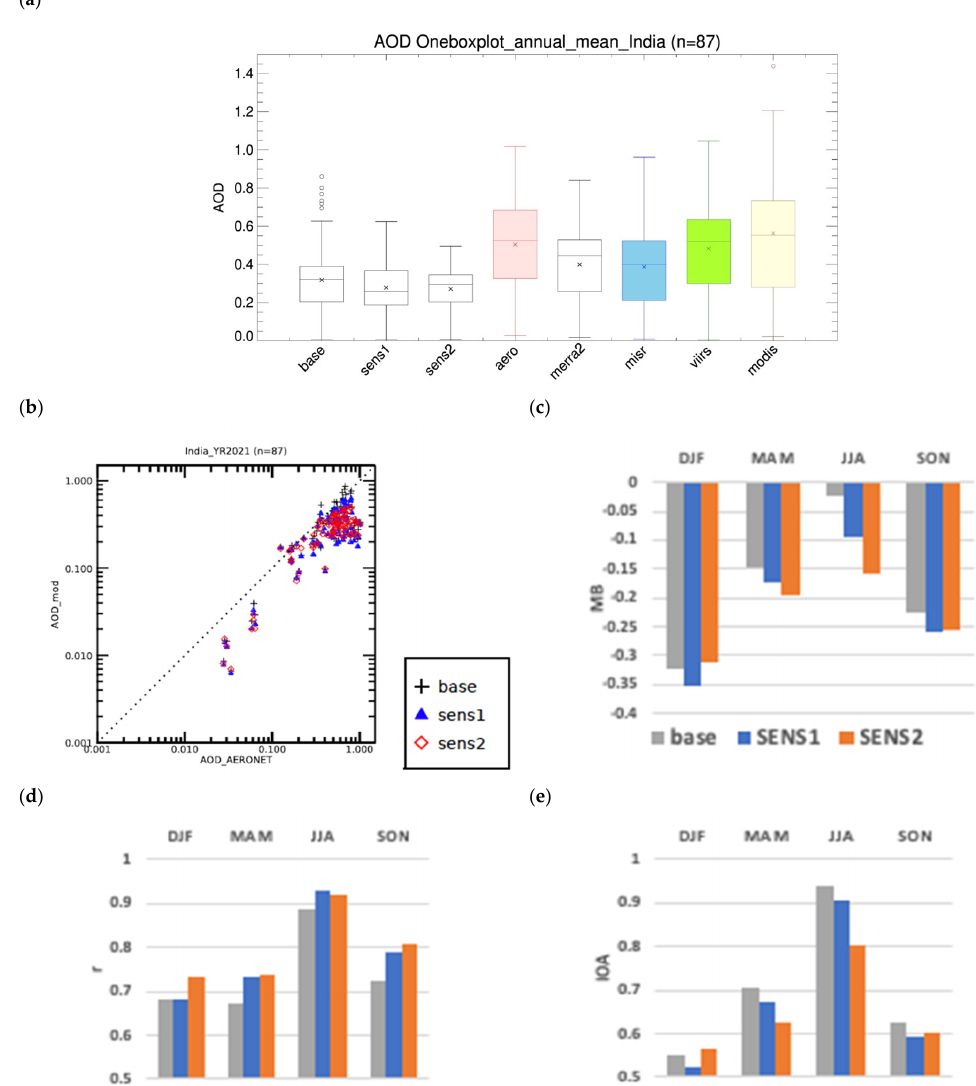
Figure 13. ( a ) The box and whisker plot of the annual AOD mean biases of BASE, SENS1 , and SENS2 (first, second, and third column in white, respectively); AERONET (in pink), MERRA2 (5th column in white); MISR (in light blue), VIIRS (in green); and MODIS (in yellow) in India. ( b ) The scatter plot of the annual simulated AODs against AERONET AODs (the 1:1 dotted line is inset). ( c ) Seasonal mean biases, ( d ) seasonal correlations, and ( e ) seasonal